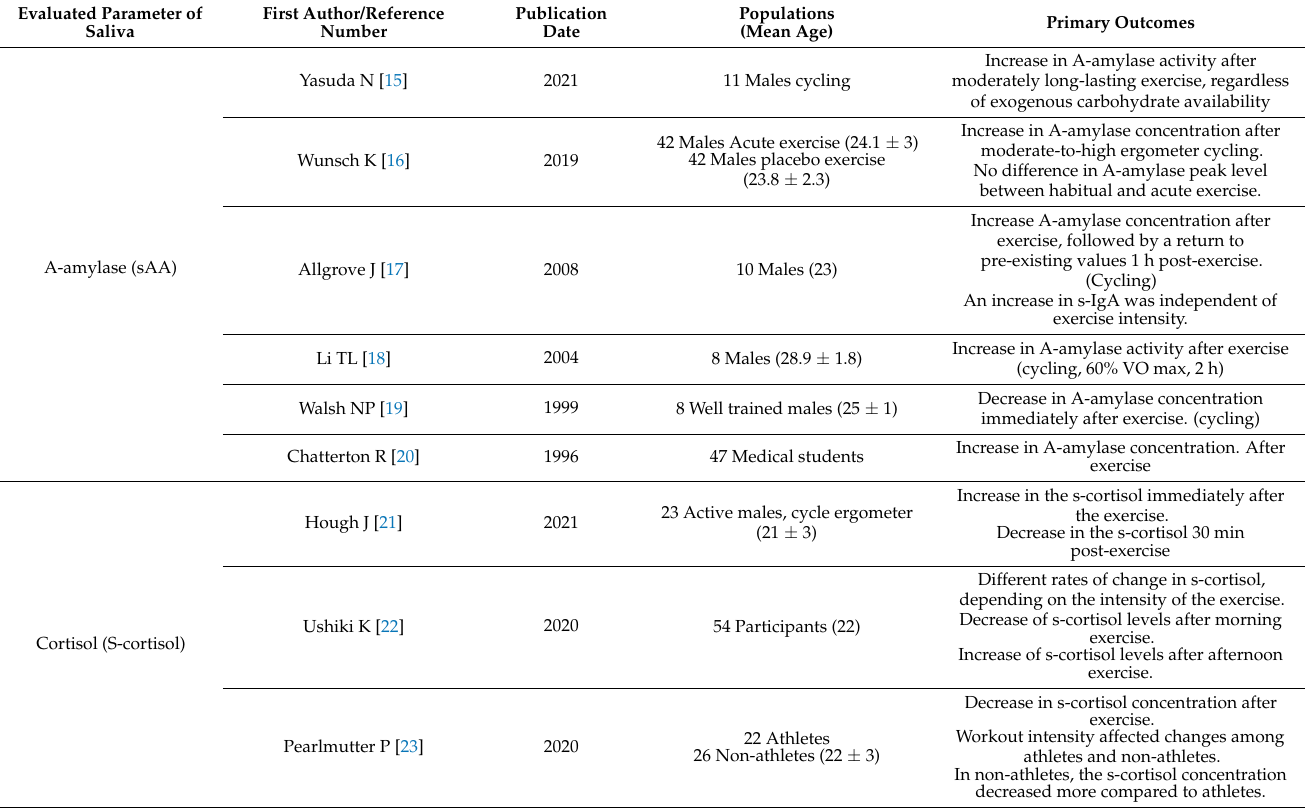
Table 1. Primary outcomes of the included studies, separately for each investigated parameter of the